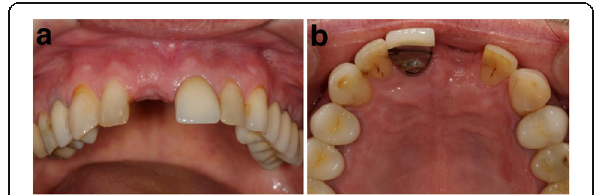
Fig. 13 a , b Clinical situation prior to implant placement